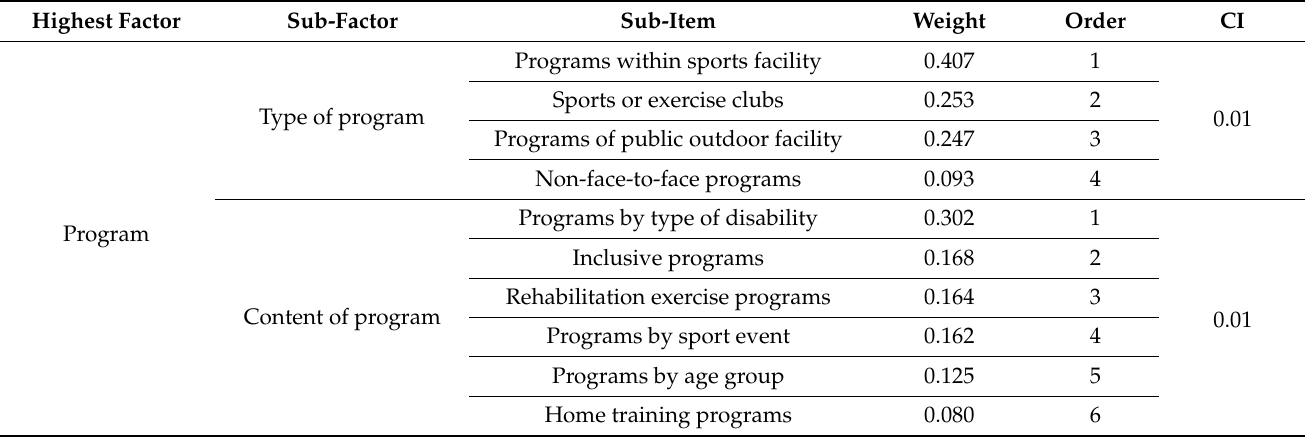
Table 7. Results of the relative importance of H4 by the program in H3.